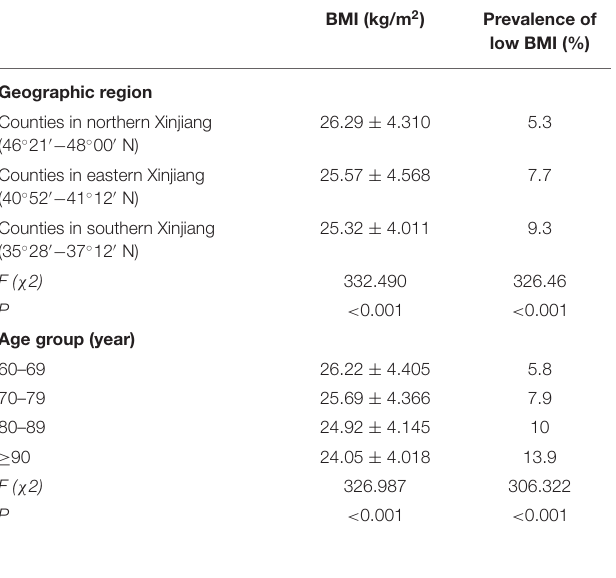
TABLE 2 | Geographic and age disparities of low BMI in the community-dwelling older people in Xinjiang.